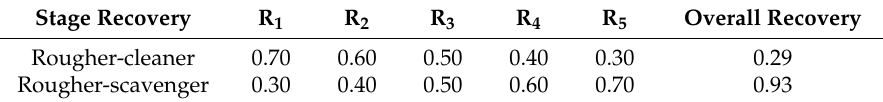
Figure 4. 5 stage countercurrent rougher-cleaner and rougher-scavenger circuits. Table 2. Optimal recovery arrangement for five stage